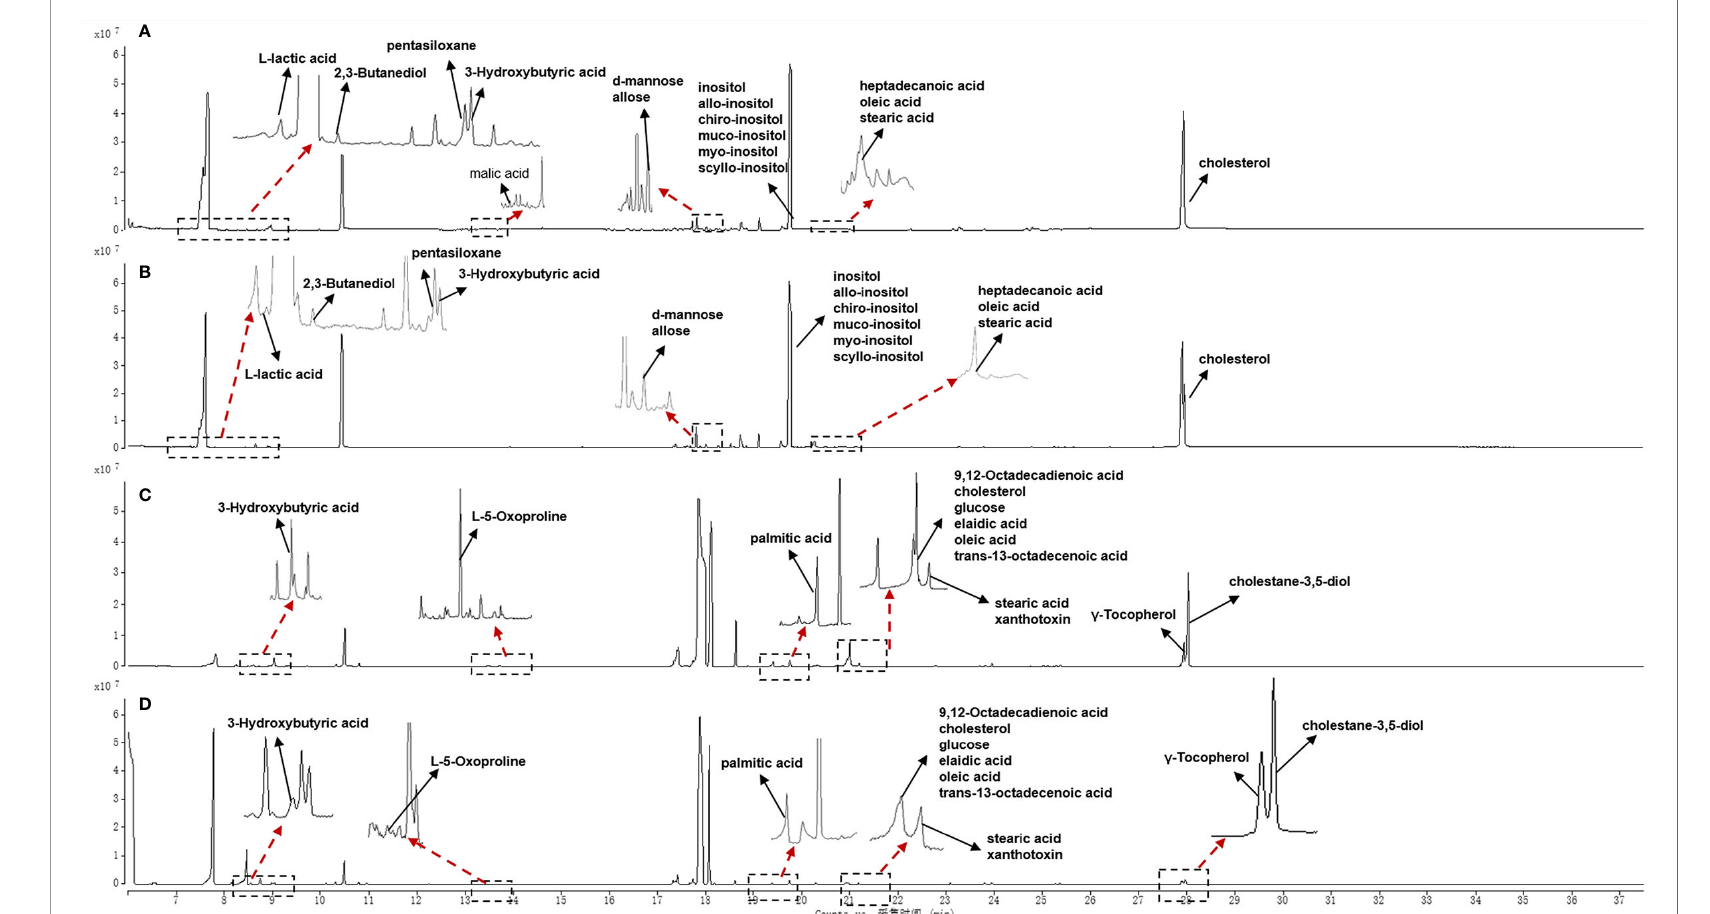
FIGURE 2 | Total ion chromatogram of cancer tissue (A) and paracarcinoma tissue (B) and preoperative (C) and postoperative (D) serum of 2 weeks in positive-ion